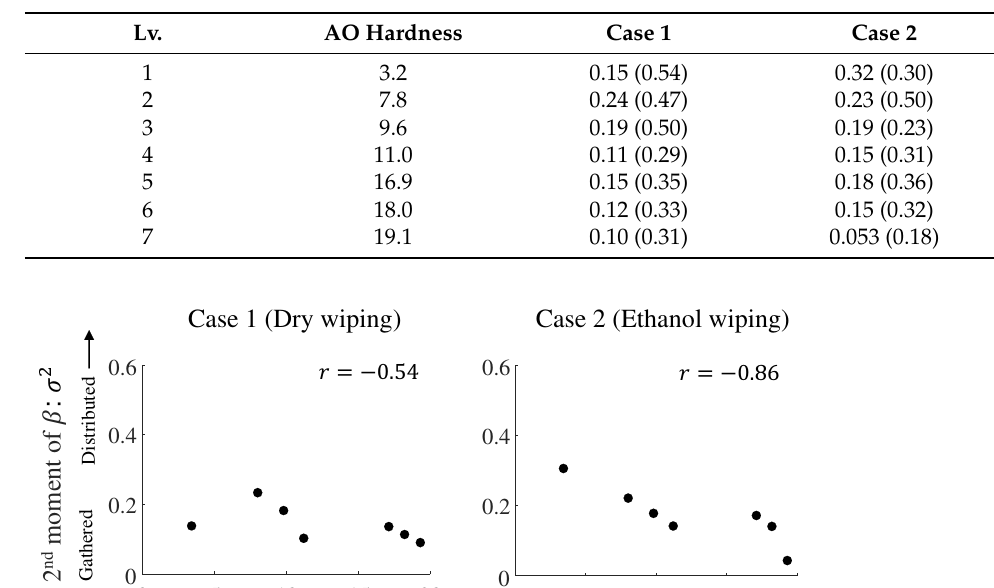
Table 2. Second moment (and interquartile range) of β under cases 1 (dry cloth) and 2 (ethanol cloth). A higher AO hardness value corresponds to a harder material, while higher values of the second moment and the interquartile range indicate greater variability of β values.